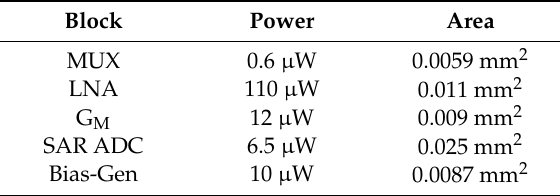
Table 1. Area and power of distribution among design